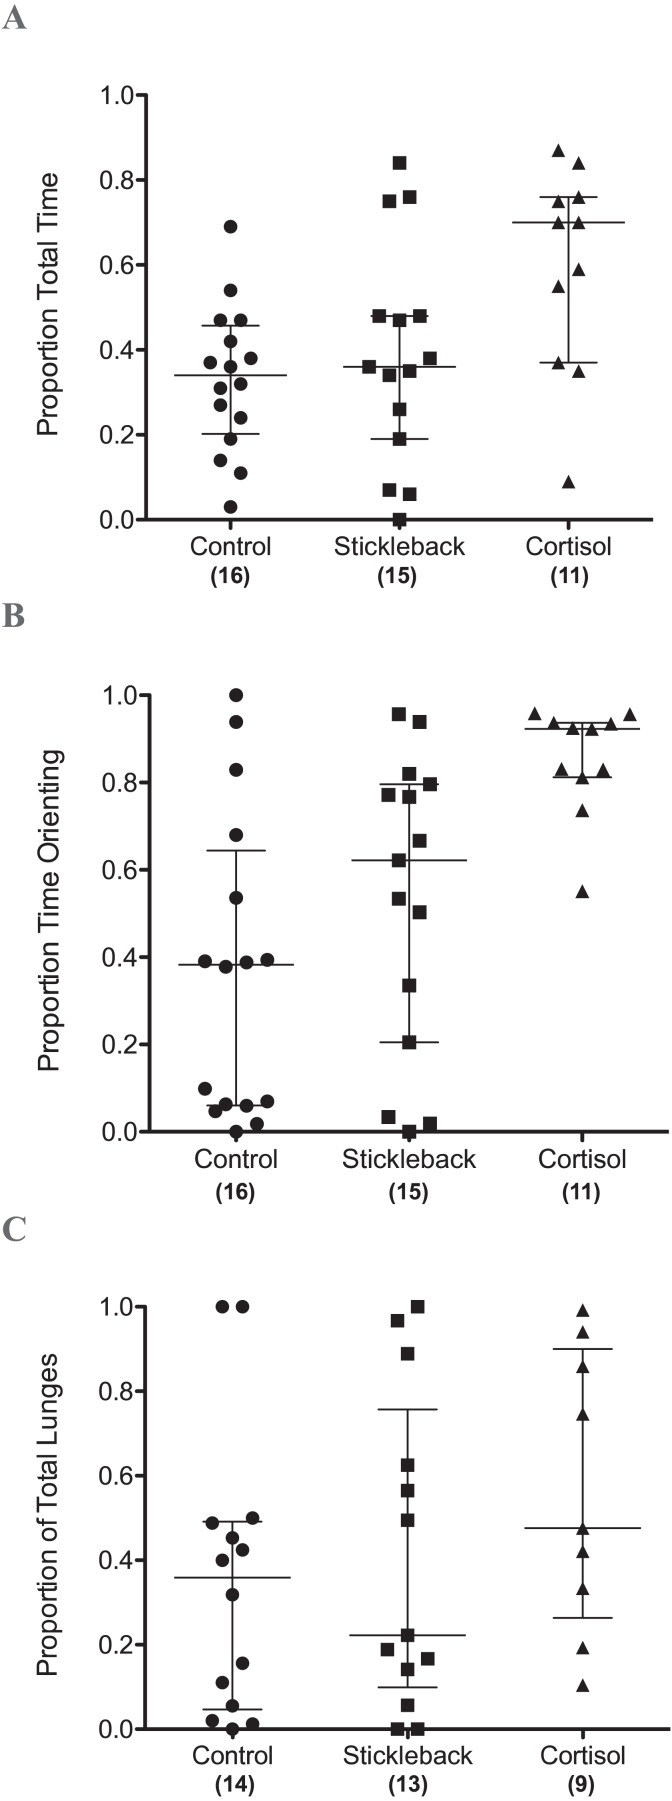
Scatter dot plots showing how chemical cues influenced perch behavior.Scatter dot plots showing median ± inter-quartile range of (A) the proportion of total time spent by perch in chemical stimulus zone, (B) the proportion of time spent by perch orientating toward sticklebacks in the chemical stimulus zone, and (C) the proportion of lunges at sticklebacks in the chemical stimulus zone.